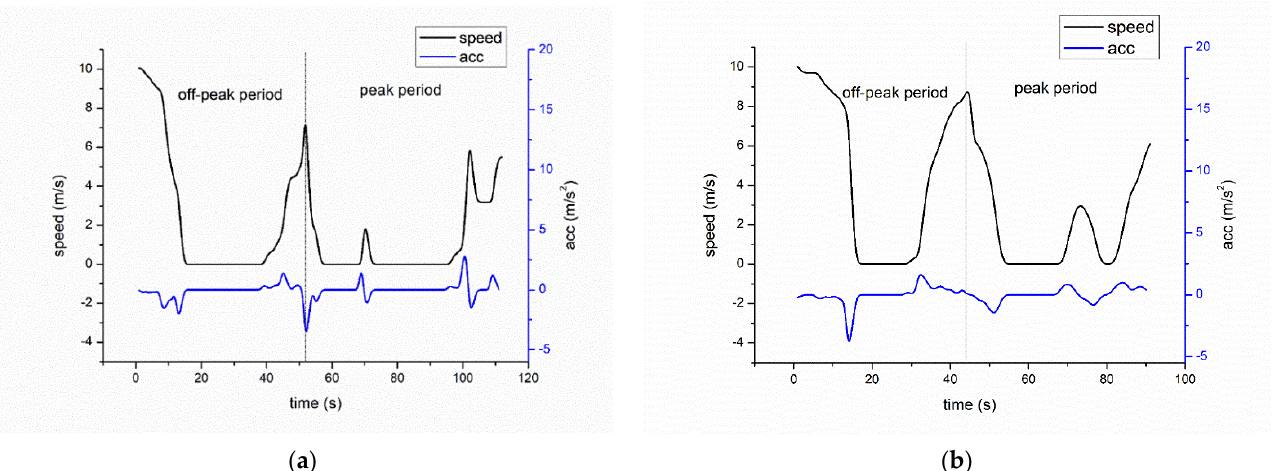
Figure 5. Driving cycle for buses near the two types of bus stops: ( a ) developed driving cycle near bus bay, ( b ) developed driving cycle near curbside bus stop.